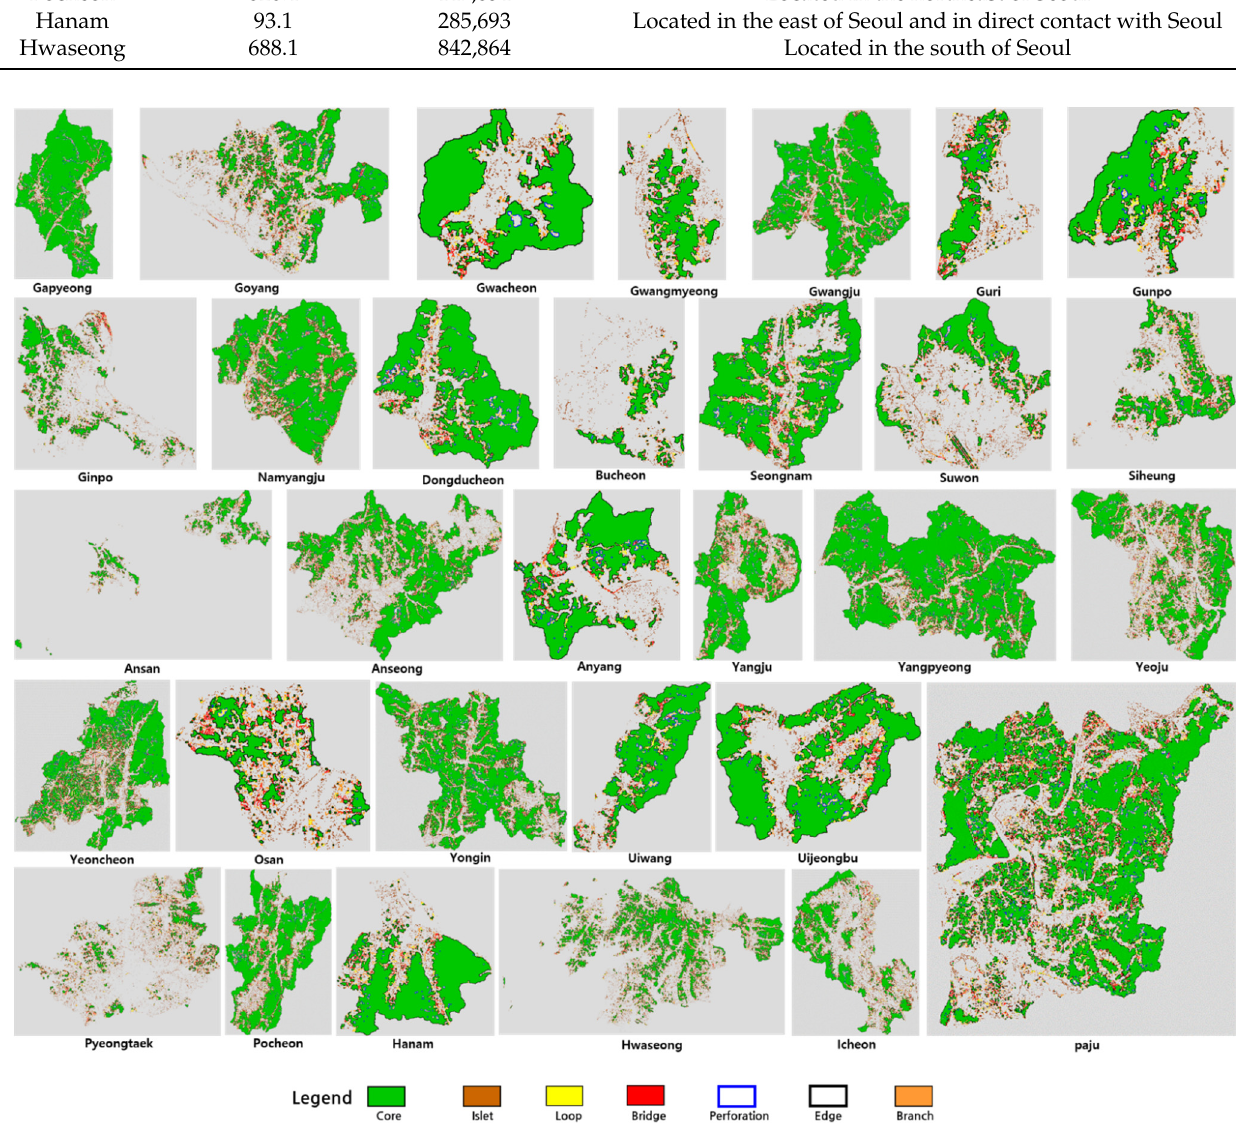
Figure A1. 1988 MSPA map of 31 cities.